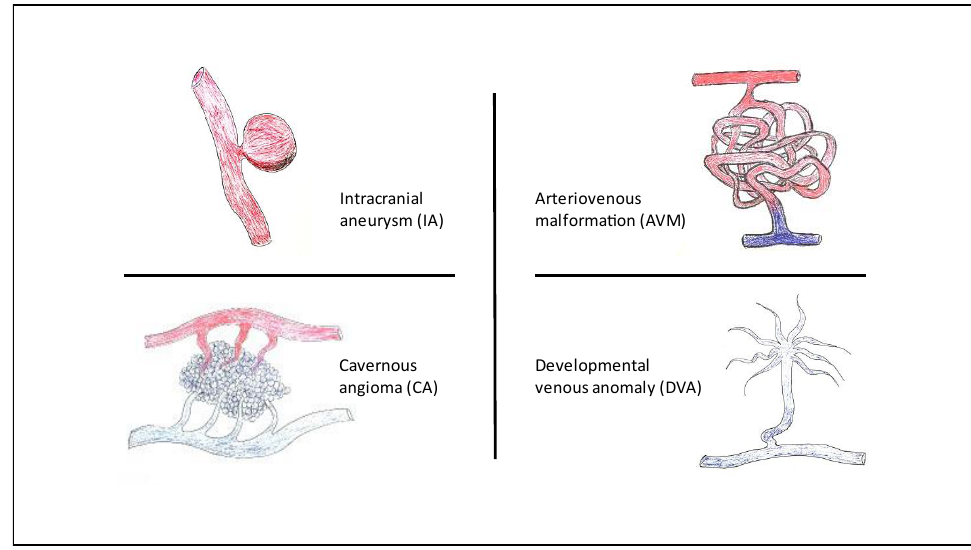
Figure 1. Types of cerebrovascular malformations found in our cohort of HHT patients.